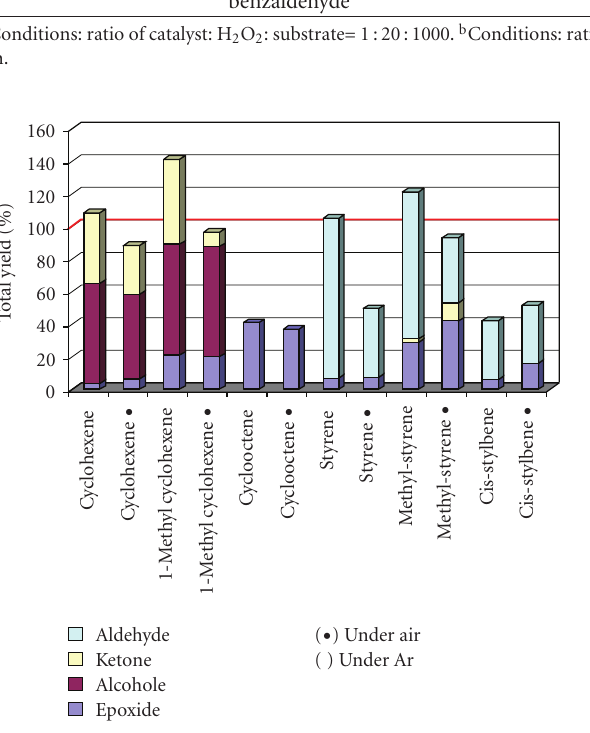
Figure 2: Bar chart representation of oxidations catalyzed by LFe III Cl with H 2 O 2 in CH 3 CN under atmospheric air and under Ar.